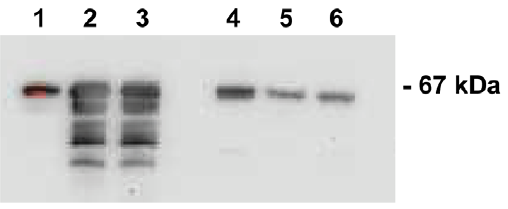
Figure 6. Western blot analysis of rat and mouse pancreas using the CDV15 antibody. Crude extracts derived from three rat pancreata (lane 1–3) and three mouse pancreata (lane 4–6) were separated by SDS-PAGE (12%), transferred to PVDF membranes, and probed with the CDV15 antibody. Partial degradation of the BSSL protein has occurred in lanes 2 and 3. 67 kDa indicates the mass of mouse and rat pancreatic BSSL. doi:10.1371/journal.pone.0047006.g006 dendritic cells into the inflamed joints [43–47]. Cxcr4 and Cxcl12 null-knockout mice are embryonic lethal [48,49] but studies using T cell-specific CXCR4-deficient mice showed that CXCR4 expression in T cells is important for the development of CIA by recruiting activated T cells toward inflammatory sites [46]. In patients with RA the frequency of CXCR4 expressing synovial tissue CD4 + memory T cells is elevated compared with normal